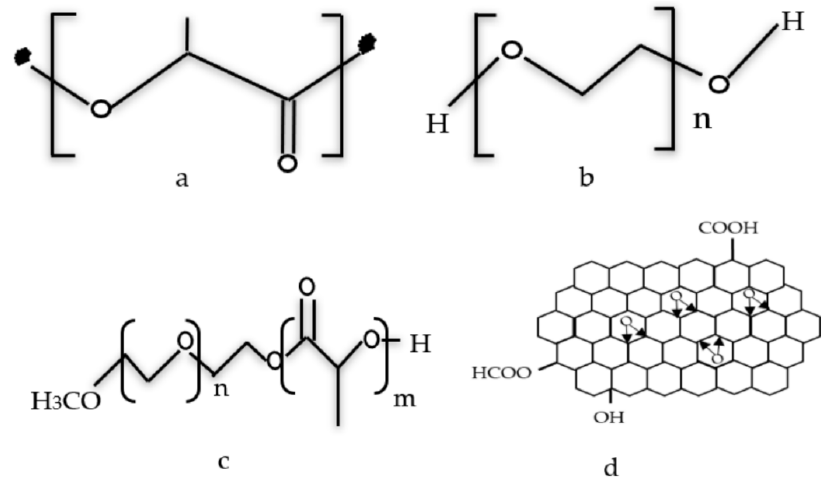
Figure 1. Chemical structures of ( a ) pure PLA, ( b ) pure PEG, ( c ) PLA/PEG mixture, and ( d ) RGO powder.